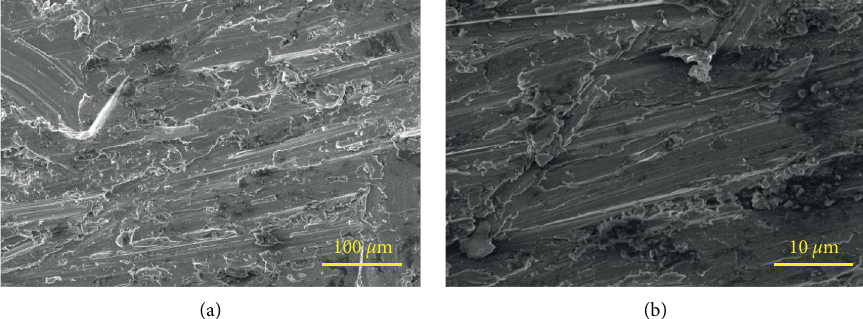
Figure 7: (a) Fatigue failure surfaces for Al-Si alloy with striations and cleavage fracture (b) Fatigue failure surfaces for Al-Si/63%SiC with striation mark.